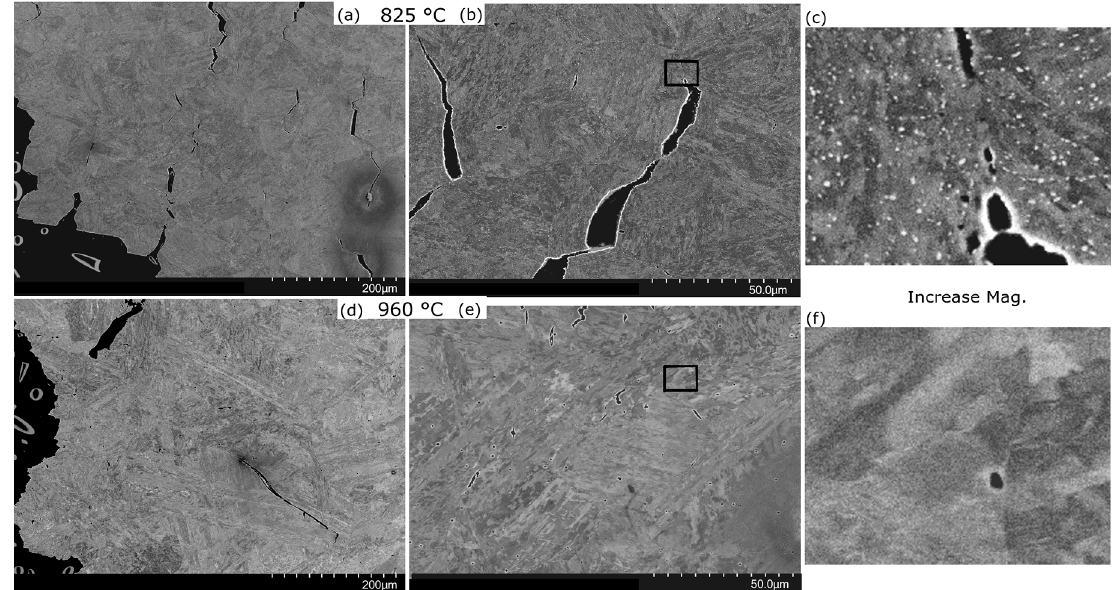
Figure 13. Back-scattered SEM images of failed creep samples. ( a – c ) after heat-treatment of 825 °C for 2 h (HT1), ( d – f ) after heat-treatment of 960 °C for 1 h (HT3); both are subsequently aged for 5 h. This alloy, which we call Alloy B, has a similar composition (more details may be found in [8] and at the start of the discussion section). Images are taken near the fracture surface on a plane parallel to the direction of load and perpendicular to the crack. The images on the ( c , f ) are taken from the